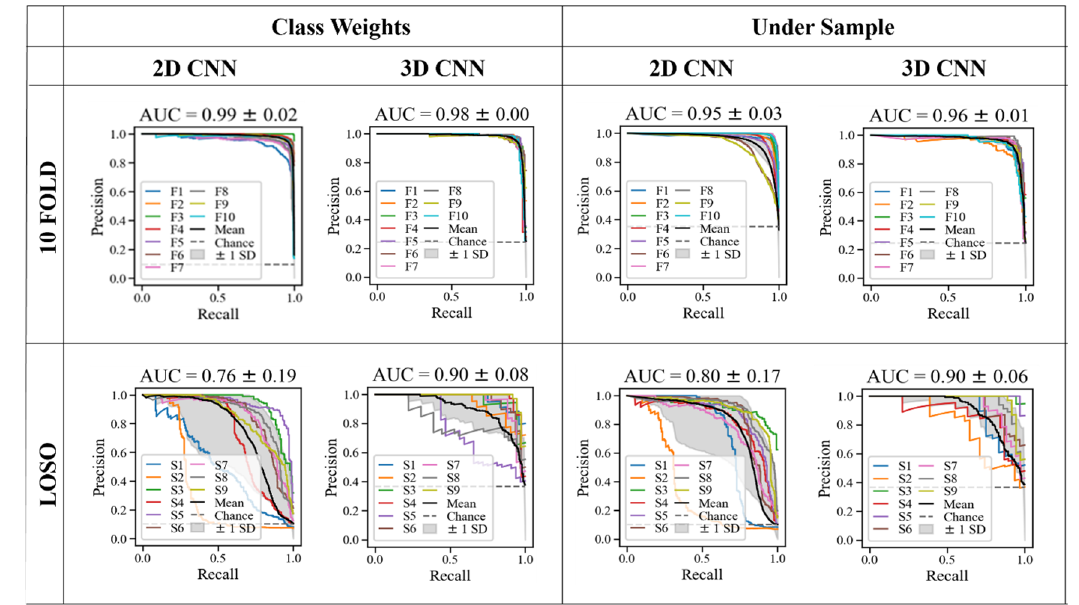
Figure 7. Precision-recall curve for the top models.